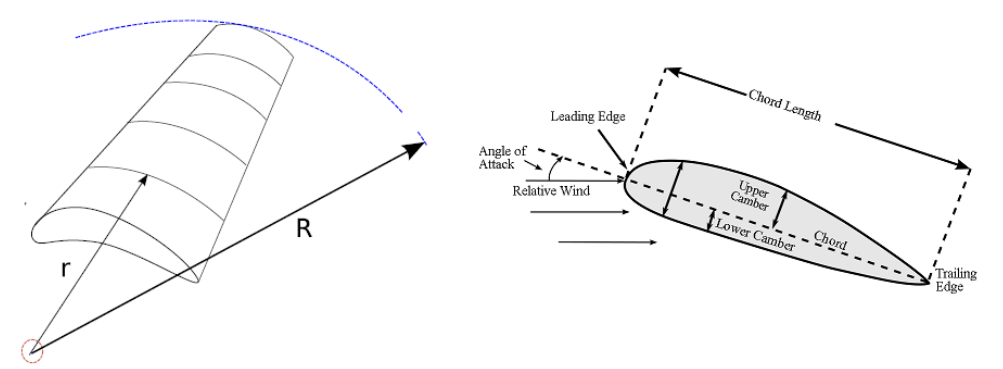
Figure 4 . Blade element model with